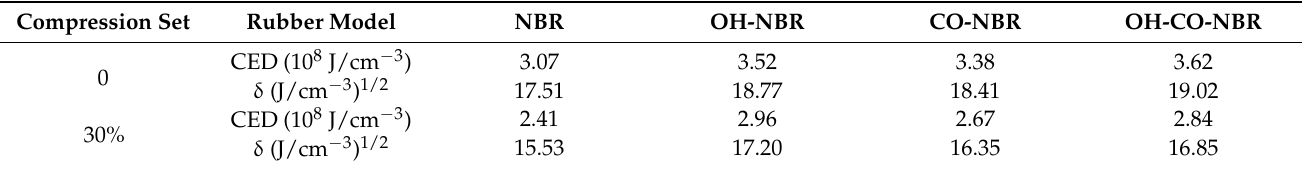
Table 4. The cohesive energy density (CED) and solubility parameters of the unaged and aged NBR